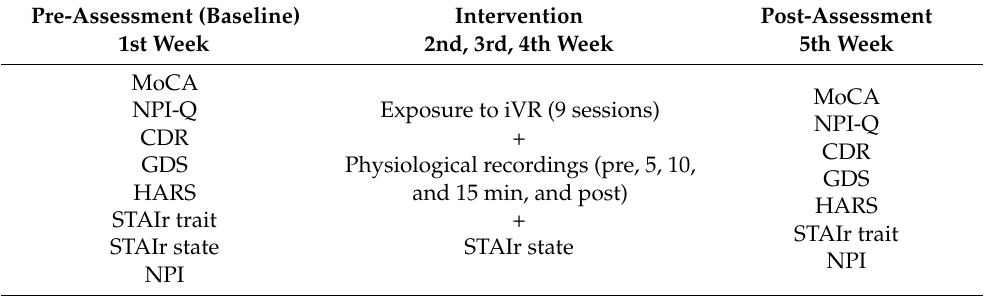
Table 3. Phases of the